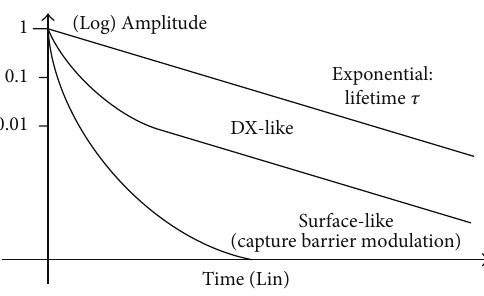
Figure 3: Semilog plots of net-capture transients derived from traps with the same emission lifetime 𝜏 but different boundary conditions during the transient. During the surface-like decay, the capture barrier increases as capture takes place (see